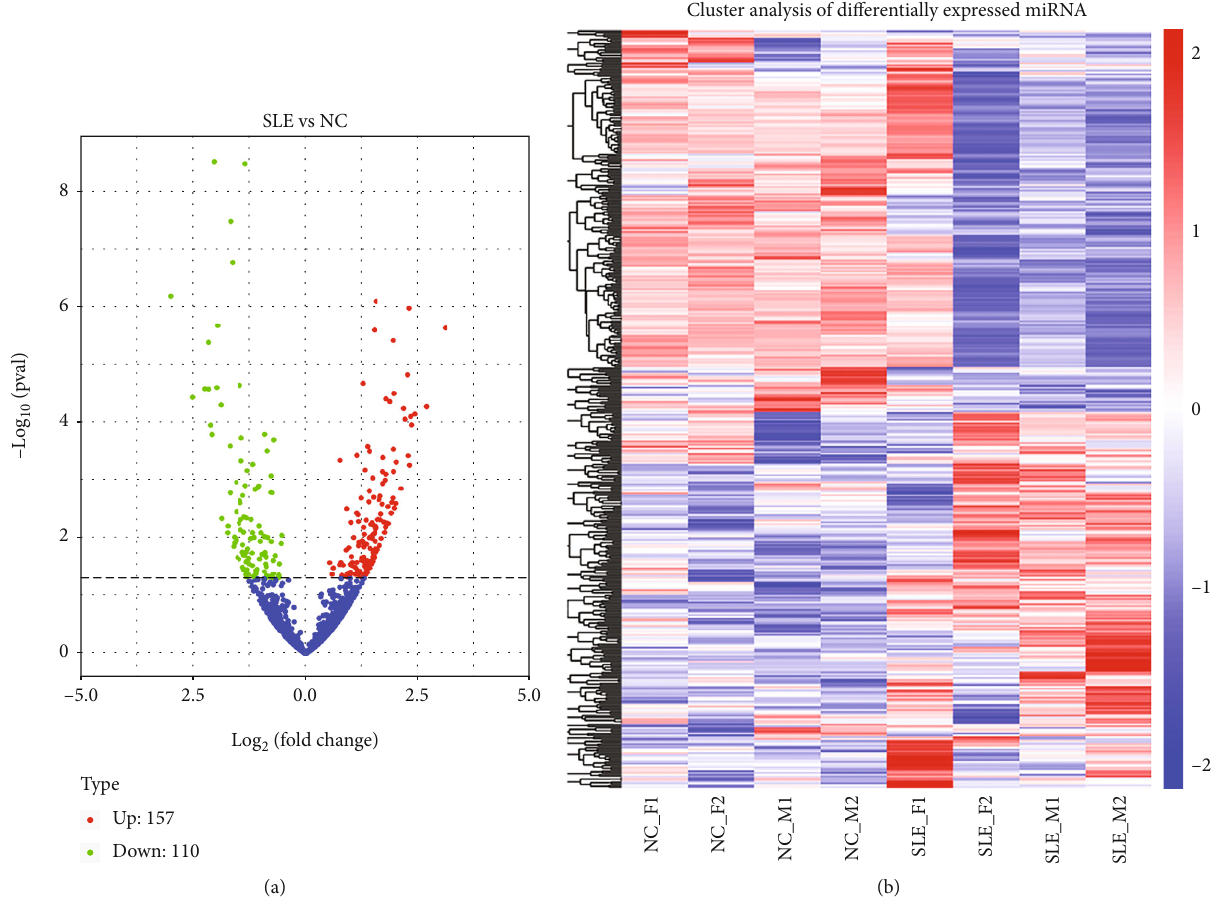
Figure 2: Volcano plot and heat map analyses. (a) Totally, 157 and 110 miRNAs were upregulated and downregulated, respectively, in SLE cases compared with controls. (b) The di ff erentially expressed miRNAs well di ff erentiated SLE cases from healthy